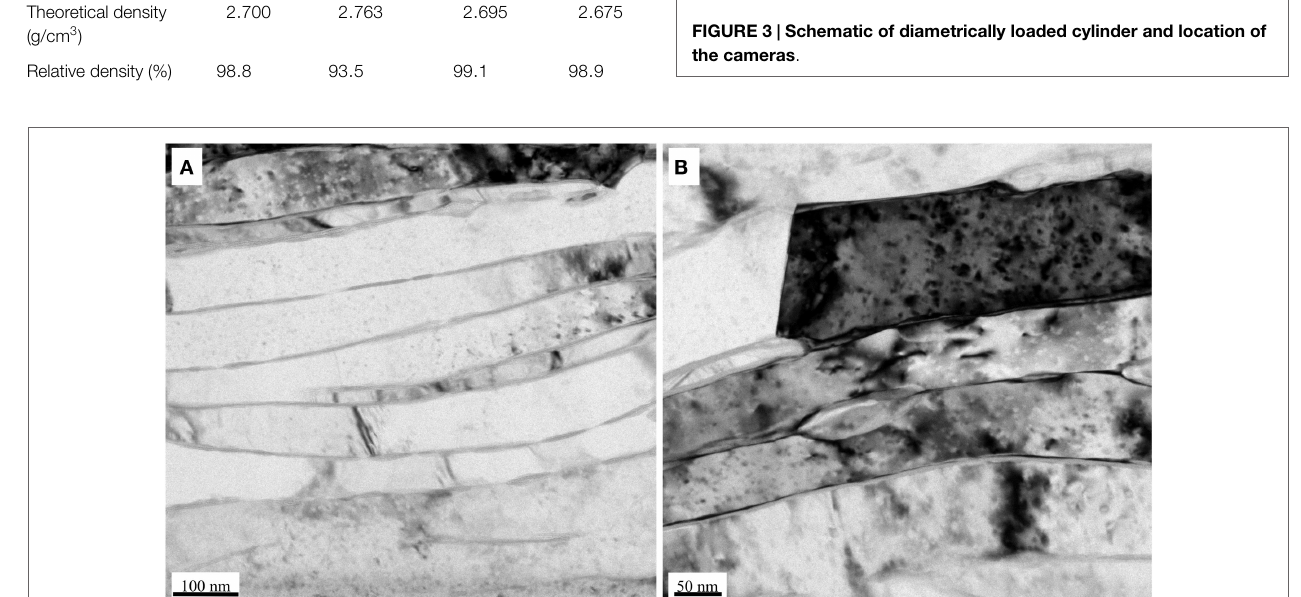
FIGURE 2 | TEM micrographs of the layered microstructure of Al–1%GNP at different magnifications .